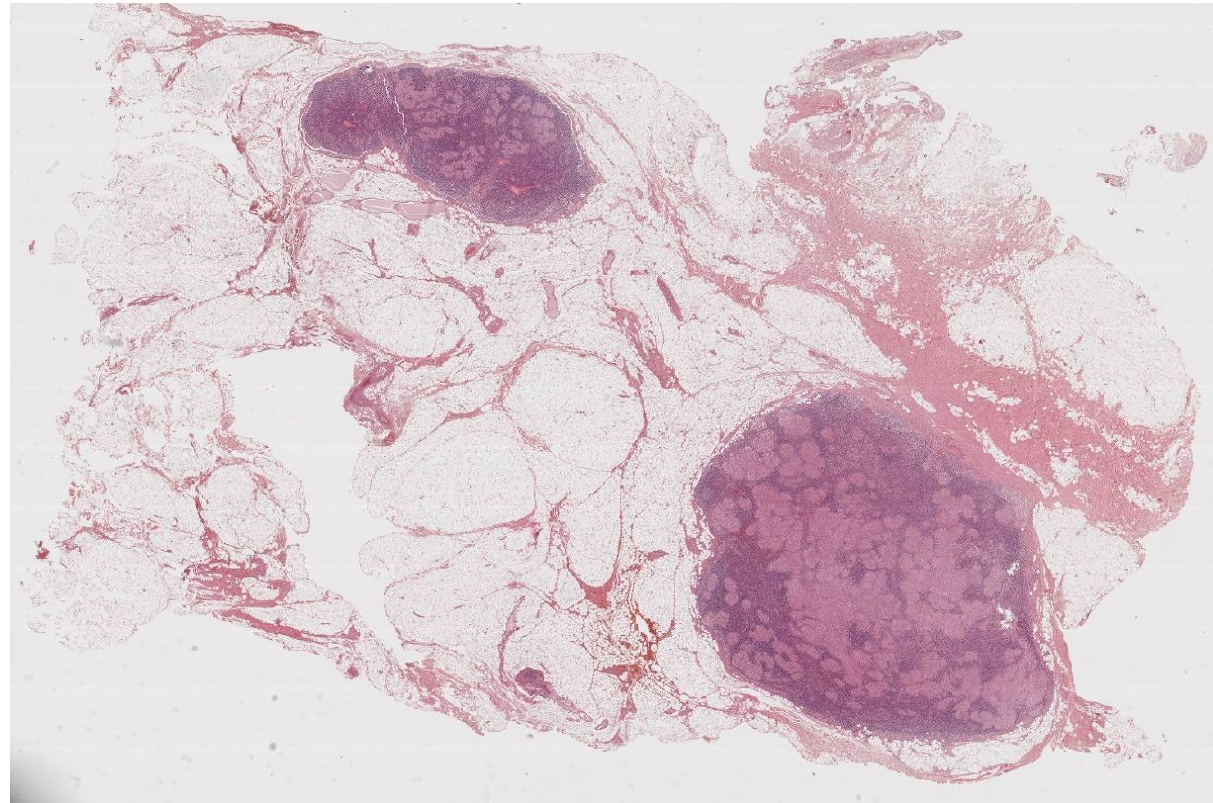
Figure 1. Lymph nodes involved in sarcoidosis. The characteristic low-power appearance of lymph nodal sarcoidosis consists of diffuse effacement of the nodal architecture by small and regular non-caseating granulomas. The pink, eosin- ophilic granulomas stand in stark contrast against the overall basophilic look of the lymph nodes. (Haematoxylin and eosin, 5×).